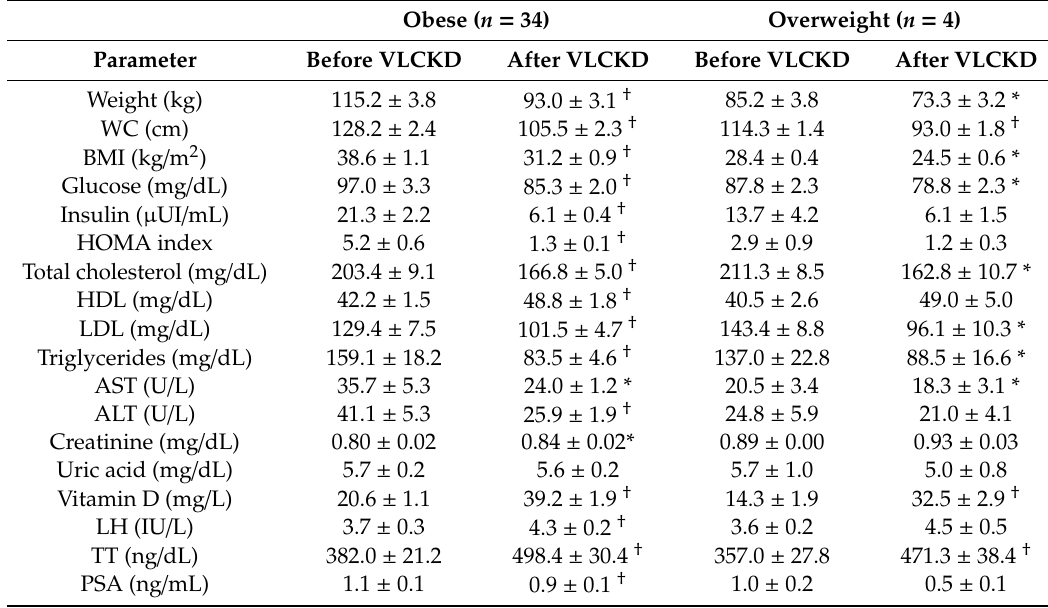
Table 2. Anthropometric, metabolic, and hormonal parameters before and after very low calorie ketogenic diet (VLCKD) in obese and overweight patients.